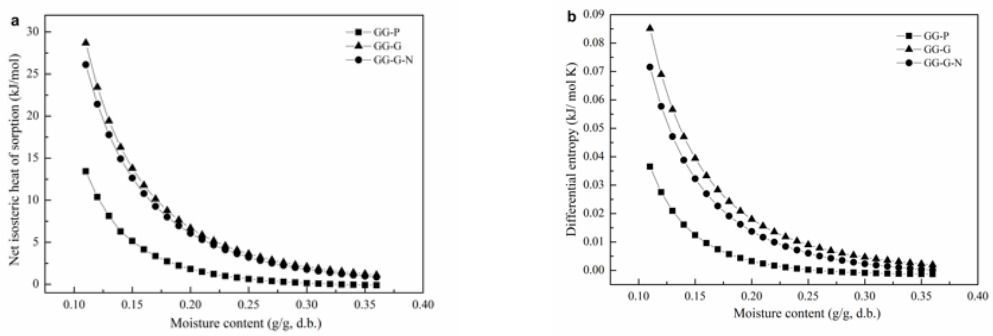
Figure 2. Net isosteric heat of sorption ( a ) and di ff erential entropy ( b ) for GG-based films as a function of moisture content.